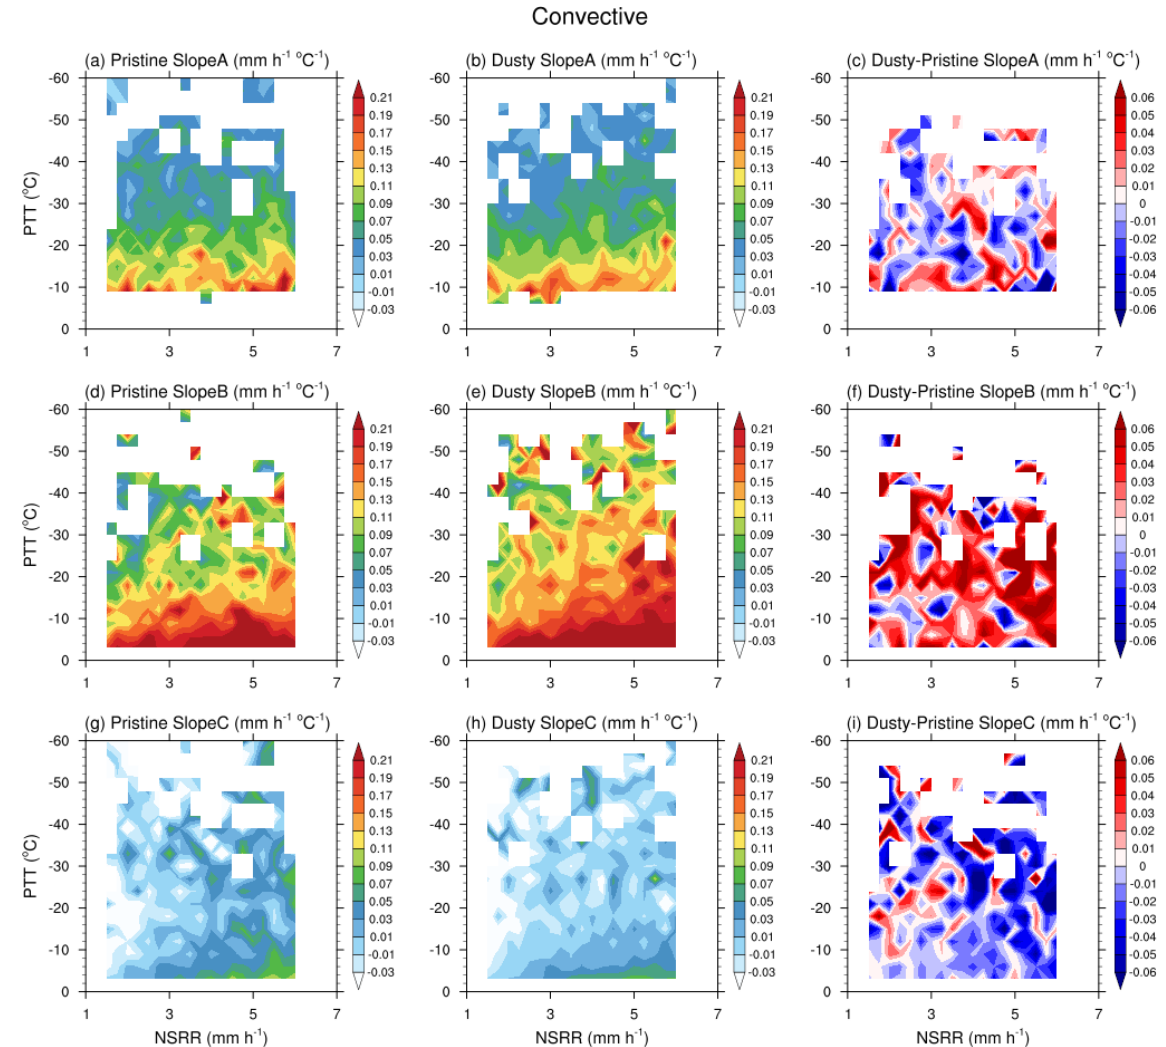
Figure 8. The same as Fig. 7 but for deep convective